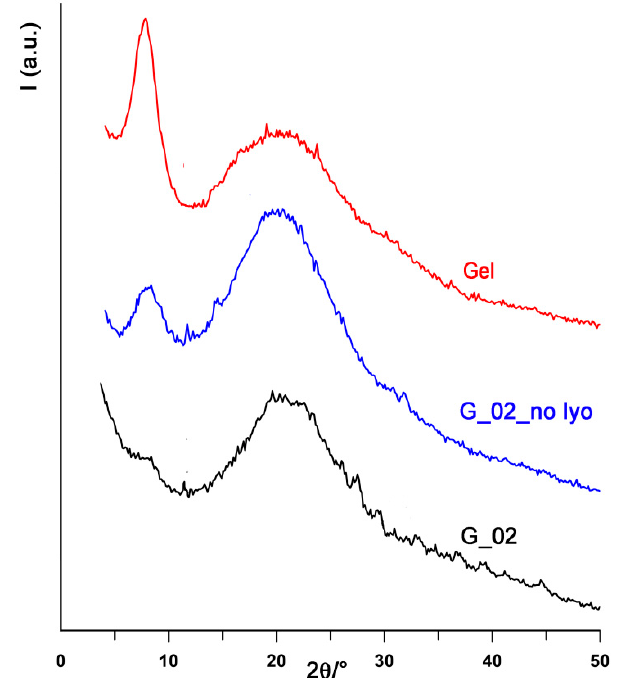
Figure 2. X-rays powder diffraction patterns recorded on gelatin foam (Gel), gelatin foam containing genipin before lyophilization (G_02_no lyo) and the same sample after lyophilization (G_02).